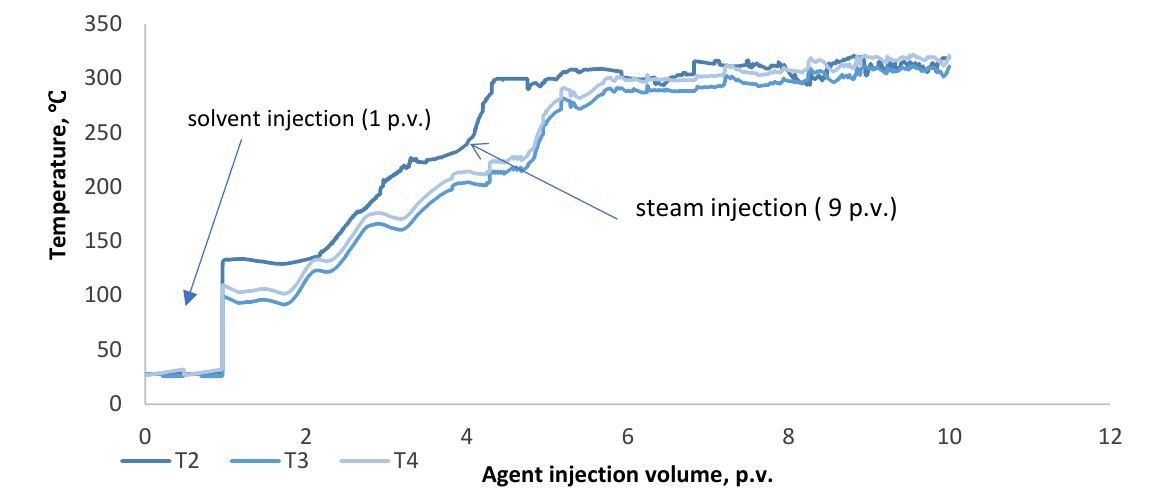
Figure 7. Temperature profiles in the experiment with steam and solvent supplied in a slug.